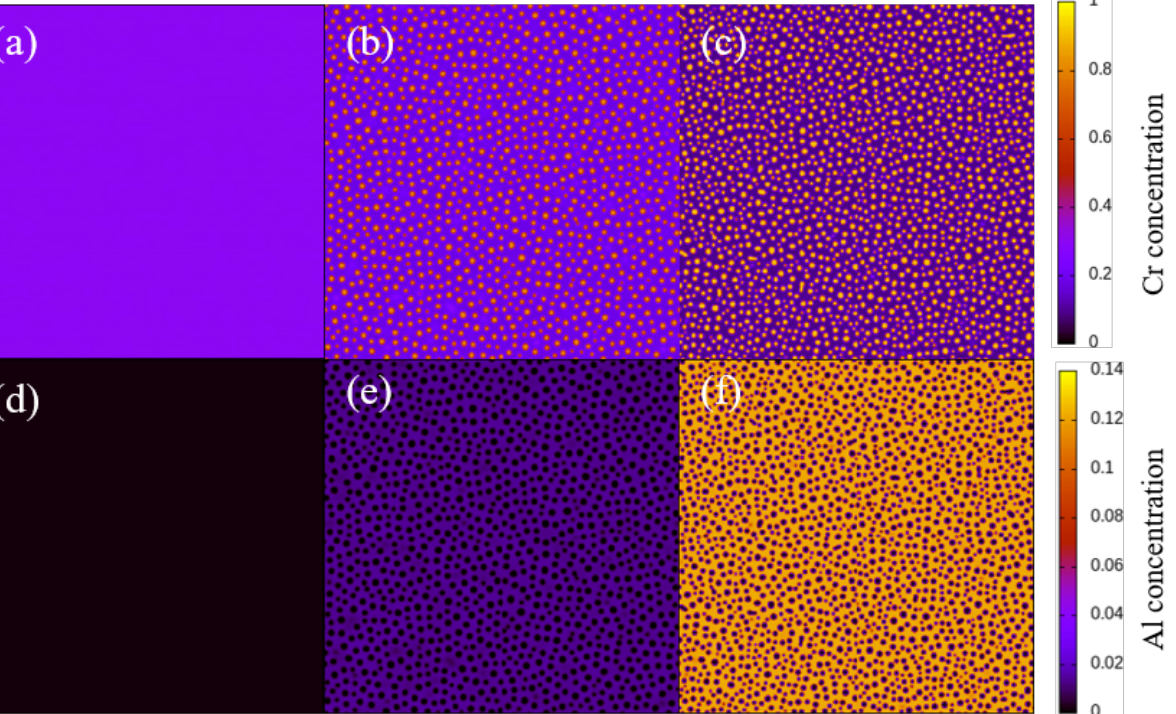
Figure 4. Plots of the Cr or Al concentration at t ∗ = 5.0 × 10 6 when the average Cr concentration was 30% and the average Al concentration was ( a , d ) 0.1%, ( b , e ) 1%, and ( c , f ) 9%. Cases ( a – c ) are plots of the Cr concentration field and cases ( d – f ) are plots of the Al concentration